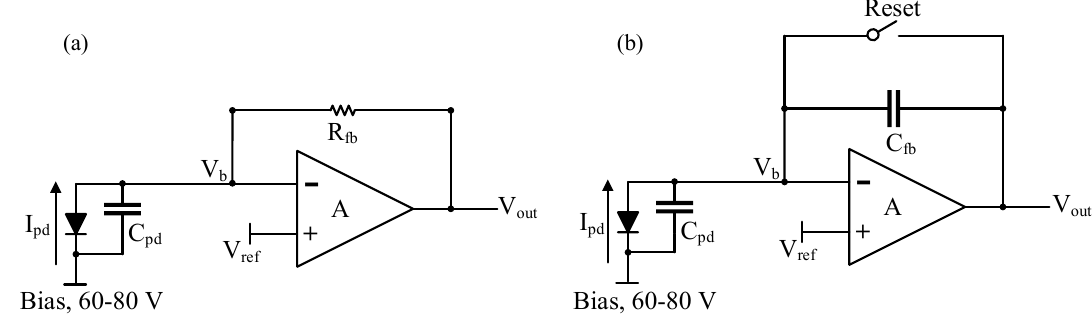
Figure 2. ( a ) Resistive transimpedance amplifier (RTIA); and ( b ) capacitive transimpedance amplifier (CTIA).